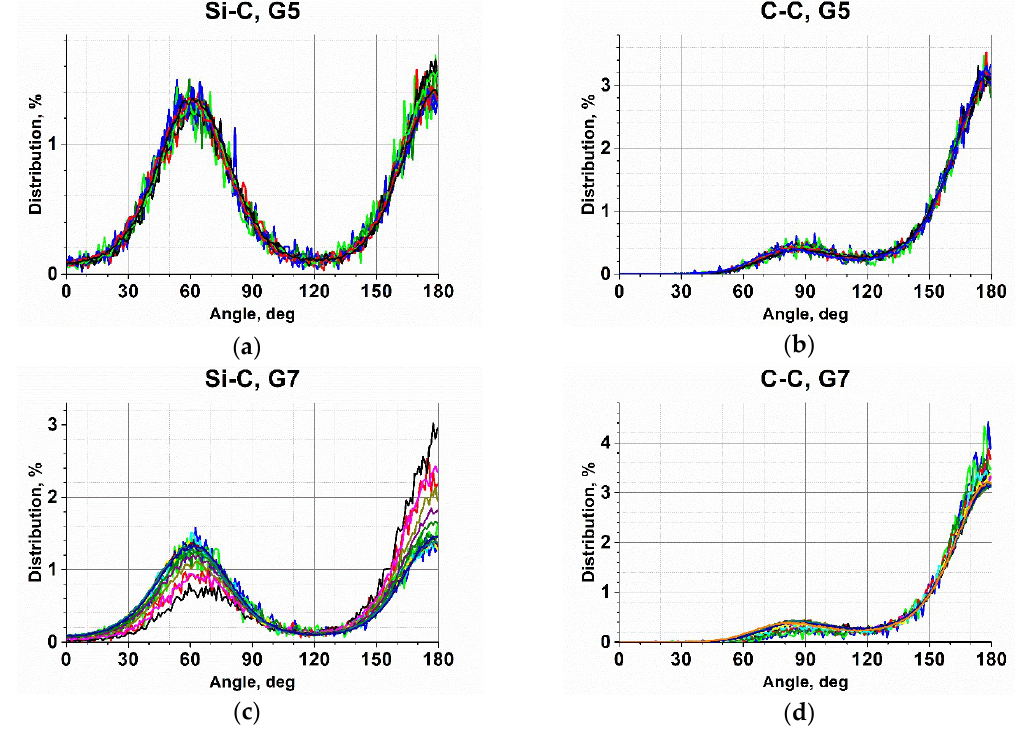
Figure 11. The distribution function of the rotational angle for the Si-C ( a , c ) and the C-C bonds ( b , d ) for the c3-dendrimers of the fifth ( a , b ) and seventh ( c , d ) generations at 300 K.